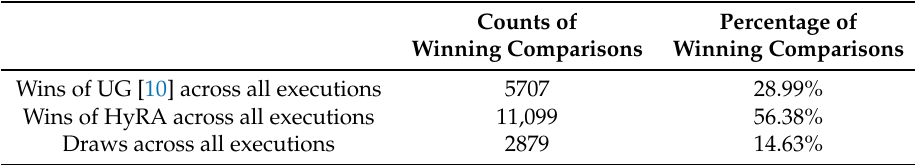
Table 14. Comparison between the UG and HyRA recommendation